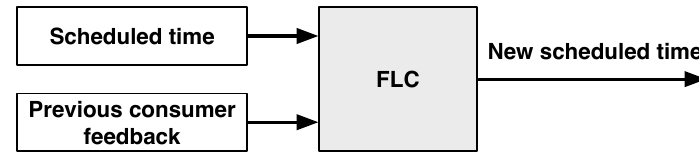
Figure 4. Proposed fuzzy logic controller (FLC)